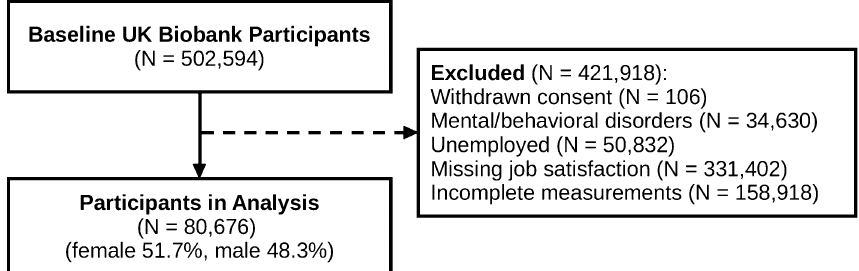
Figure 2. Overview of Study